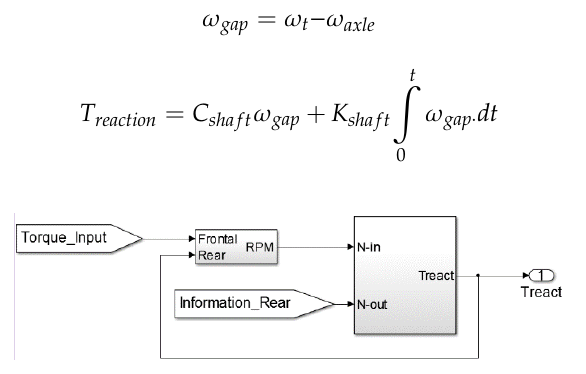
Figure 5. Flexible shaft module.